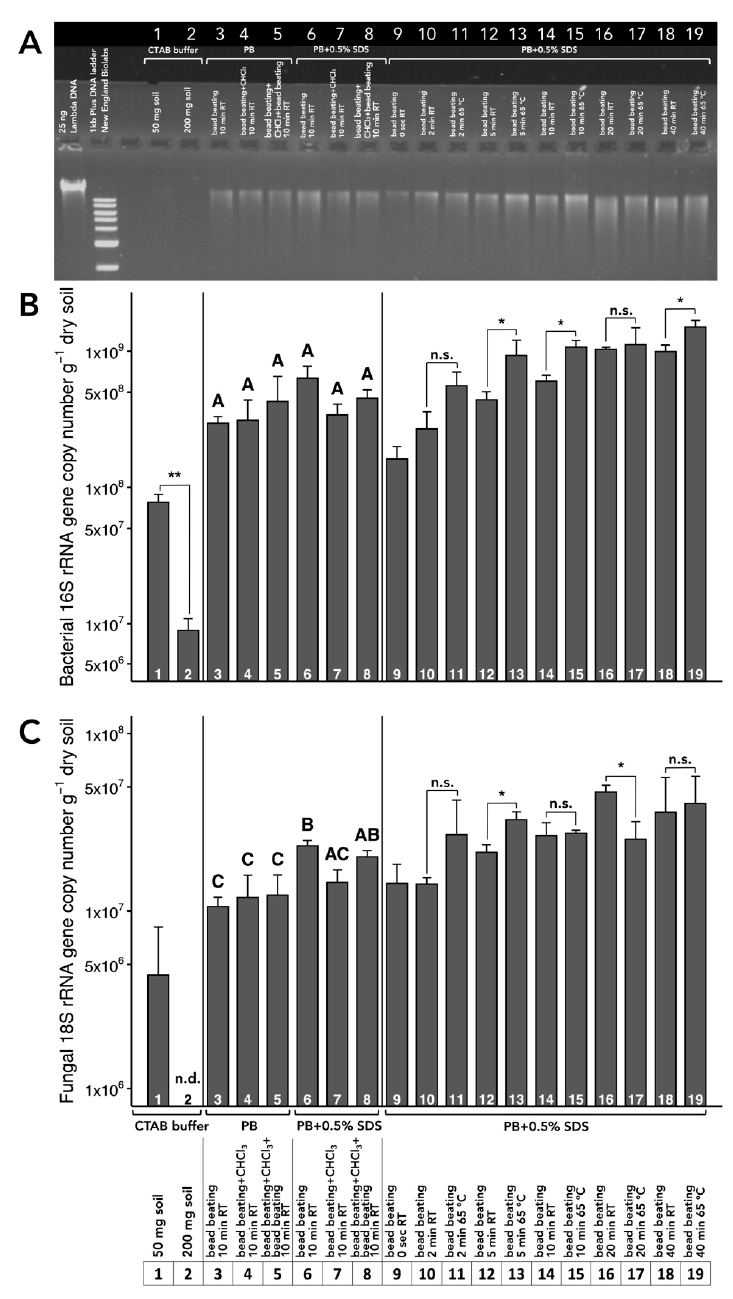
Figure 3. Comparison of DNA obtained with different extraction protocols and copy number of rRNA genes determined by qPCR. ( A ) Separation of extracted DNA in 1.7% agarose gel. Samples loaded onto the gel were pooled from three technical replicates shown in Figure S1. ( B ) Abundance of bacterial 16S rRNA. ( C ) Abundance of fungal 18S rRNA. Differences between two groups of samples (e.g., 1 and 2 or 10 and 11) were tested using student’s t ‐ test (* p < 0.05). Differences among more than two groups of samples (e.g., 3 to 8) were tested using ANOVA with Tukey HSD. Different uppercase letters indicate statistically significant differences at p < 0.05. n.d. = not detectable; n.s. = no statistically significant differences; PB = phosphate buffer; RT = room temperature; SDS = sodium dodecyl sulfate.